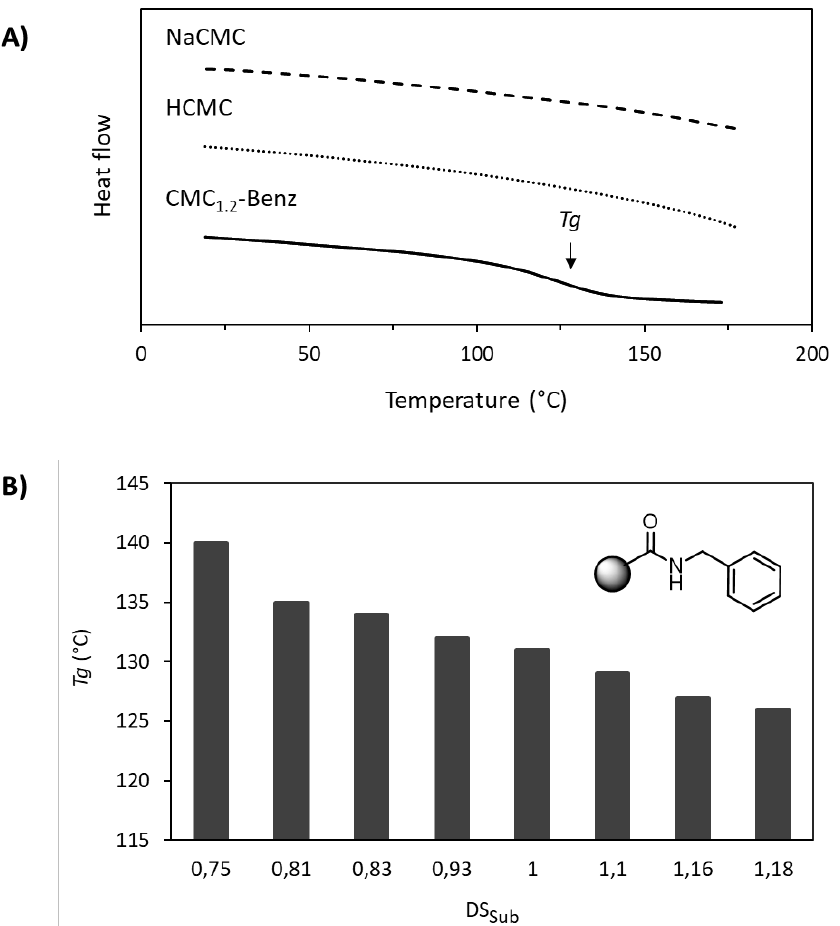
Figure 9. ( A ) Di ff erential scanning calorimetry (DSC) curves of NaCMC, HCMC and CMC 1.2 -Benz Figure 9. A) Differential scanning calorimetry (DSC) curves of NaCMC, HCMC and CMC 1.2 -Benz (Table 1, Entry 3); ( B ) Evolution of T g values of the amidated CMC-Benz derivatives as a function of DS Sub